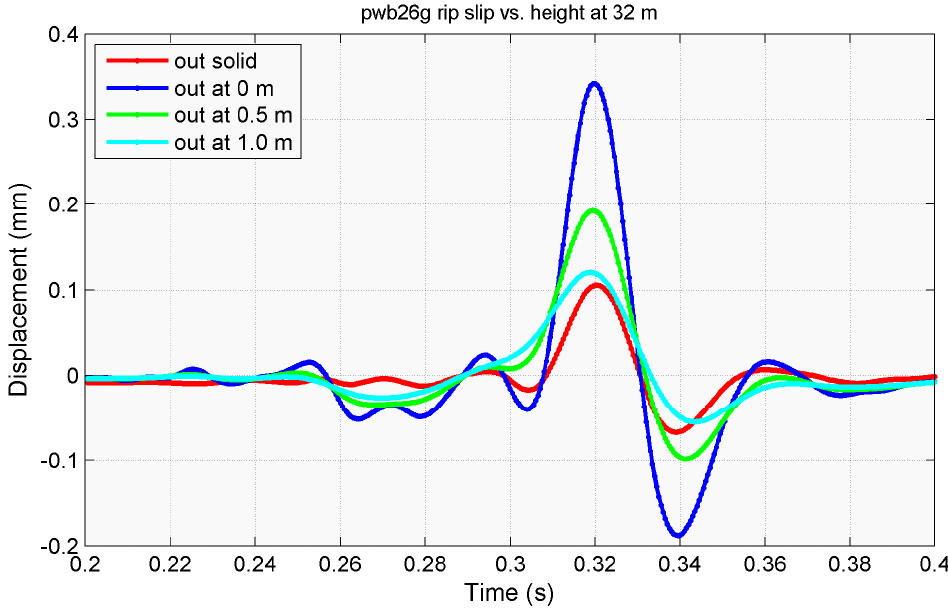
Figure 13. Horizontal water motion adjacent to the seabed differs from the solid motion.